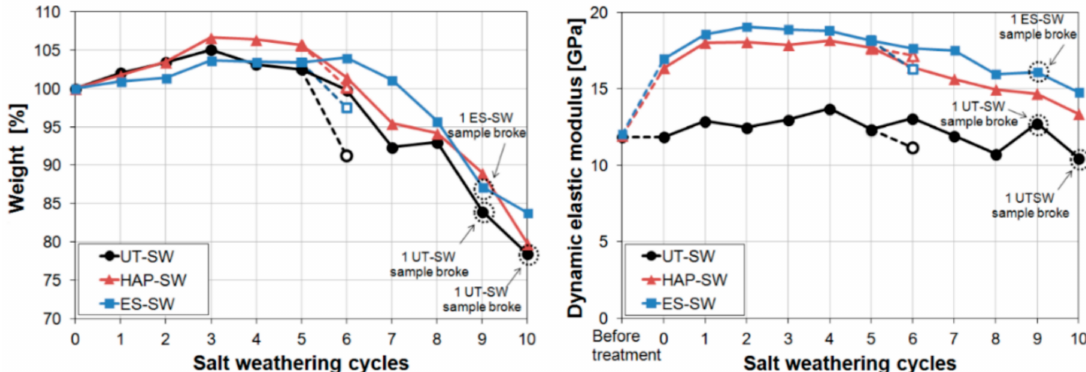
Figure 12. Variations in weight ( left ) and E d ( right ) of Globigerina limestone subjected to salt crystallization cycles (SW), untreated (“UNTR”) and treated with a 3 M DAP solution followed by a limewater poultice (“HAP”) and with a commercial ethyl silicate (“ES”). Before testing, the “ES” samples were left to cure for 1 month, then the residual hydrophobicity was eliminated by application of a water poultice [87]. Open symbols indicate values of samples desalinated after the 5th cycle. Image reprinted from Reference [50] with permission from